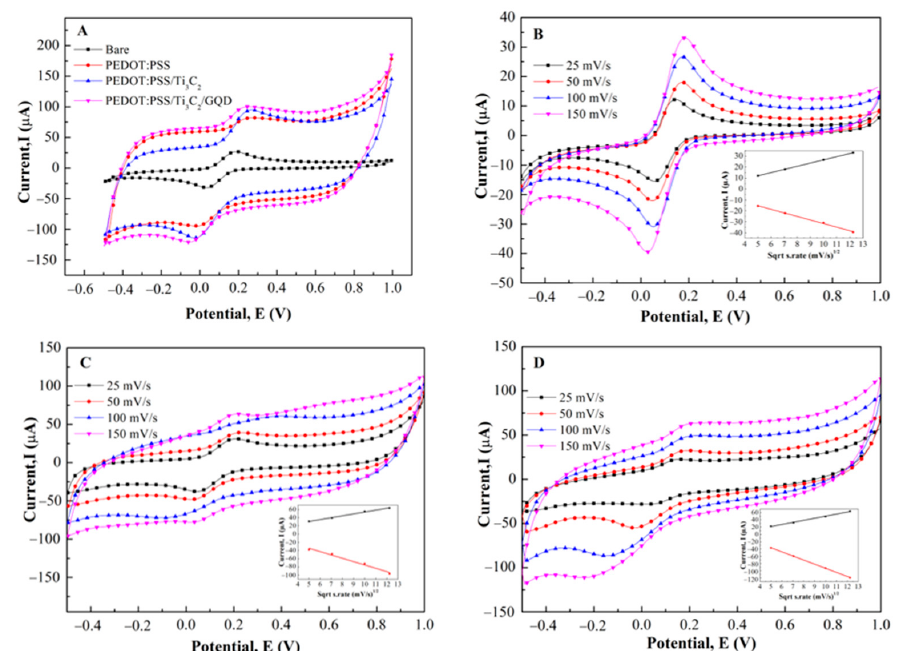
Figure 4. ( A ) CV measurements of SPCE/PEDOT:PSS/Ti 3 C 2 /GQD (Pink) compared to SPCE/PE- DOT:PSS (Red), PEDOT:PSS/Ti 3 C 2 (blue) and bare SPCE (Black) in 0.1 M K 3 [Fe(CN) 6 ] with ammo- nium acetate solution at pH 7. CV measurement of ( B ) Bare SPCE, ( C ) SPCE/PEDOT:PSS/Ti 3 C 2 , and ( D ) SPCE/PEDOT:PSS/Ti 3 C 2 /GQD at various scan rates 25, 50, 100 and 150 mV/s. Anodic Peak cur- area